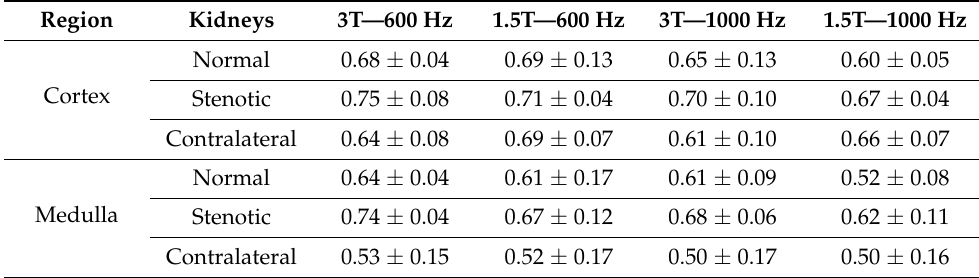
Table 1. Magnetization transfer ratios (MTR) in normal, stenotic, and contralateral kidneys at 1.5T and 3T and 600 Hz and 1000 Hz offset frequencies.